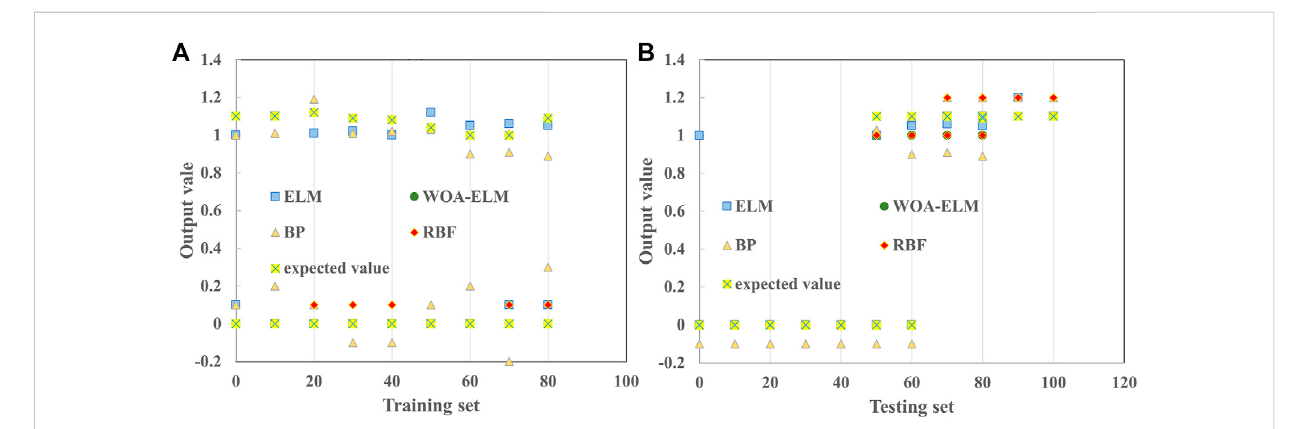
FIGURE 8 Desired output and actual output of 72 training samples (A) and testing samples (B)